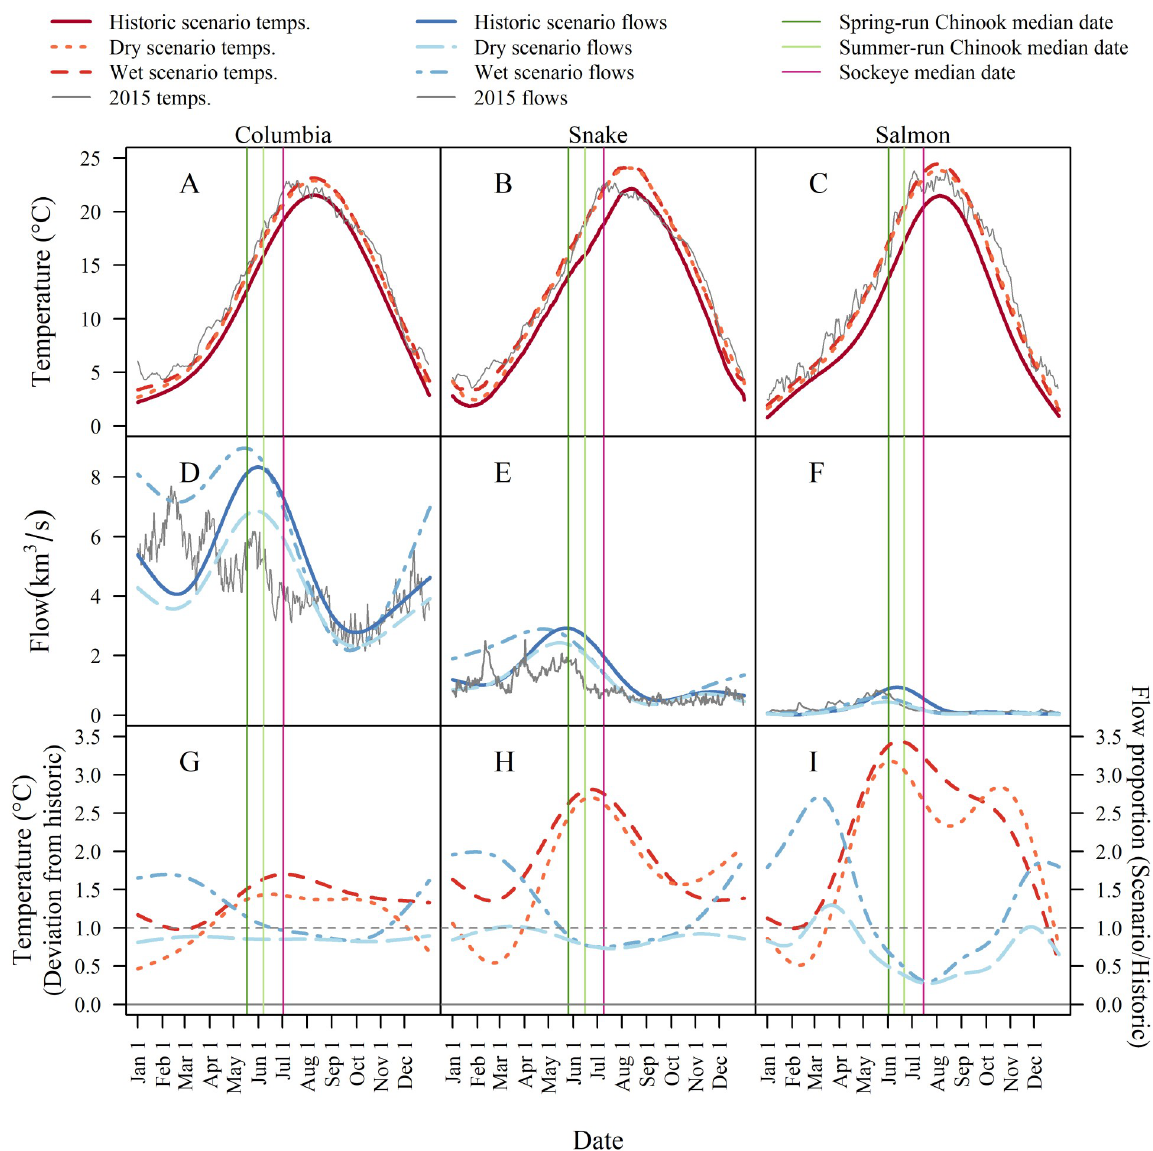
Fig 4. Projected mean daily temperature (A-C) and flow (D-F) in the Columbia, Snake, and Salmon River reaches under three climate scenarios (historical, dry, and wet). The bottom row shows the difference between modeled future and historical daily means. Vertical lines depict current median run dates for spring-run Chinook, summer-run Chinook, and